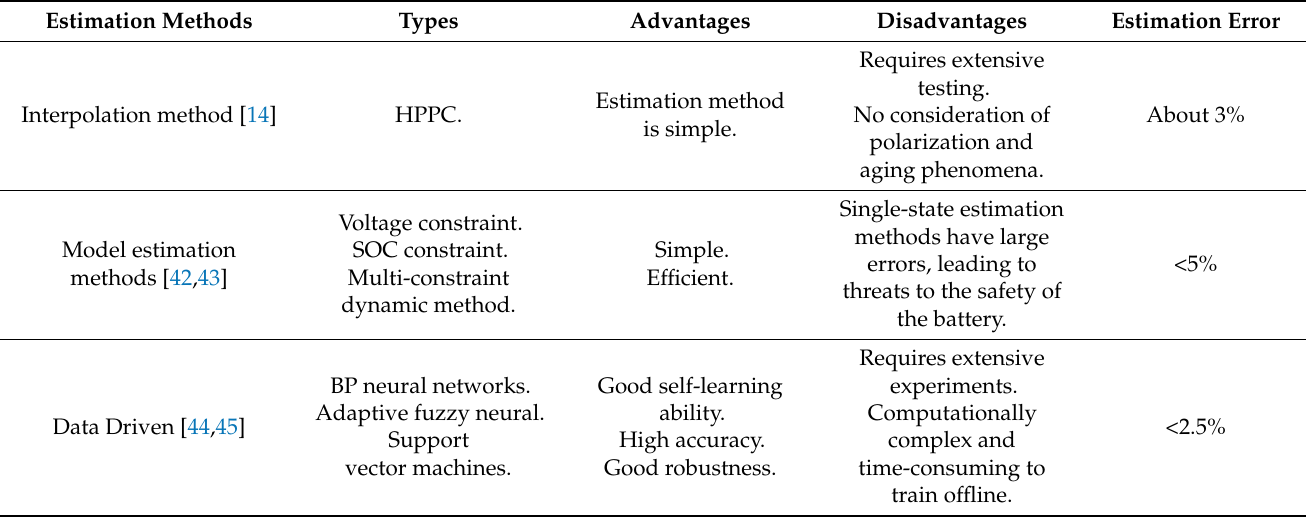
Table 4. Advantages and disadvantages of SOP-estimation methods for Li-ion